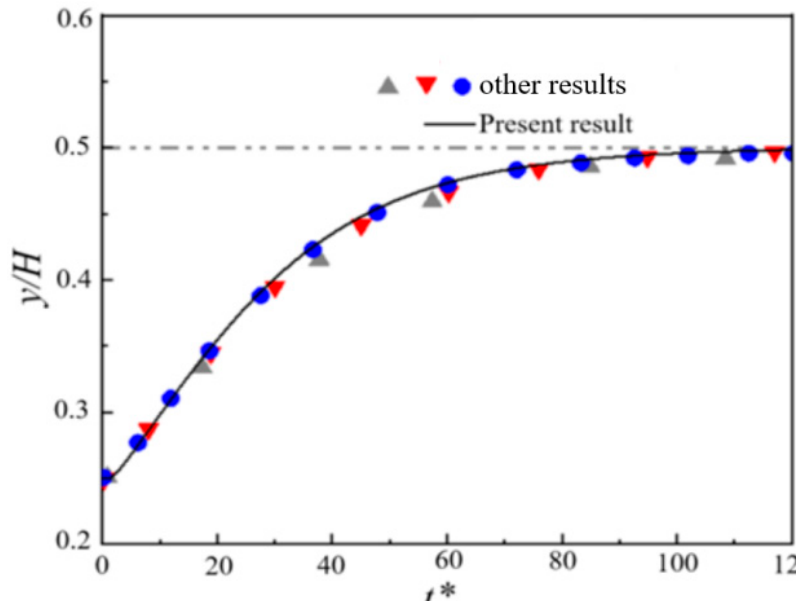
Figure 4. Comparison of trajectory in a shear flow. 3.2. Flow Induced by the Squirmer The locomotion of an elliptical squirmer in an infinite flow is simulated numerically. The squirmer is initially placed at the center of the flow with its long axis parallel to the x -axis and moves along x positive direction by treadmilling. The size of the computa- tional domain is H × L = 500 δ x × 800 δ y ( δ x and δ y are grid size), which is confirmed to be big enough to ignore the influence of boundaries. Moving mesh technology is applied, and the grid independence test has been performed. Reis defined as Re = 2 ρ U c r c / μ = ρ B 1 r c / μ , where U c is swimming velocity of the squirmer, ρ is fluid density, μ is fluid vis- cosity and r c is equivalent radius of the squirmer ( π r c 2 = area of the elliptical squirmer). AR = b / a = (1 − α )/(1 + α ) (0 ≤ α <1). Streamline and velocity induced by the elliptical squirmer with different AR at Re = 0.01 are shown in Figure 5 where the black arrows indicate the direction of squirmer swimming, and dark black lines represent flagella on the head and tail of the squirmer. We can see that, for the neutral squirmer in (a), the streamline and velocity are fore-aft symmetric, and there are some differences in the shape of streamline distribution for the squirmer with different AR because the slip velocity component is related to α (AR = (1 − α )/(1 + α )), which is consistent with the conclusion in the rod squirmer [13]. The flows